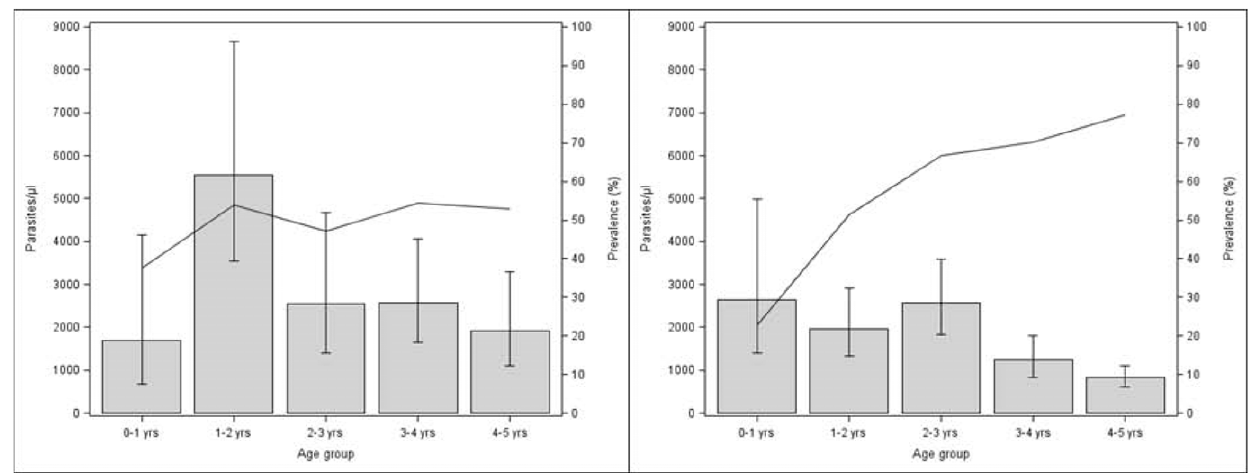
Figure 2. Prevalence of parasitemia and geometric mean parasite densities according to the season. a. Age-specific prevalence of parasitemia and geometric mean parasite densities in the high transmission season. Line indicates parasitemia prevalence. Bars indicate geometric parasite density and 95% confidence interval. b. Age-specific prevalence of parasitemia and geometric mean parasite densities in the low transmission season. Line indicates parasitemia prevalence. Bars indicate geometric parasite density and 95% confidence interval.